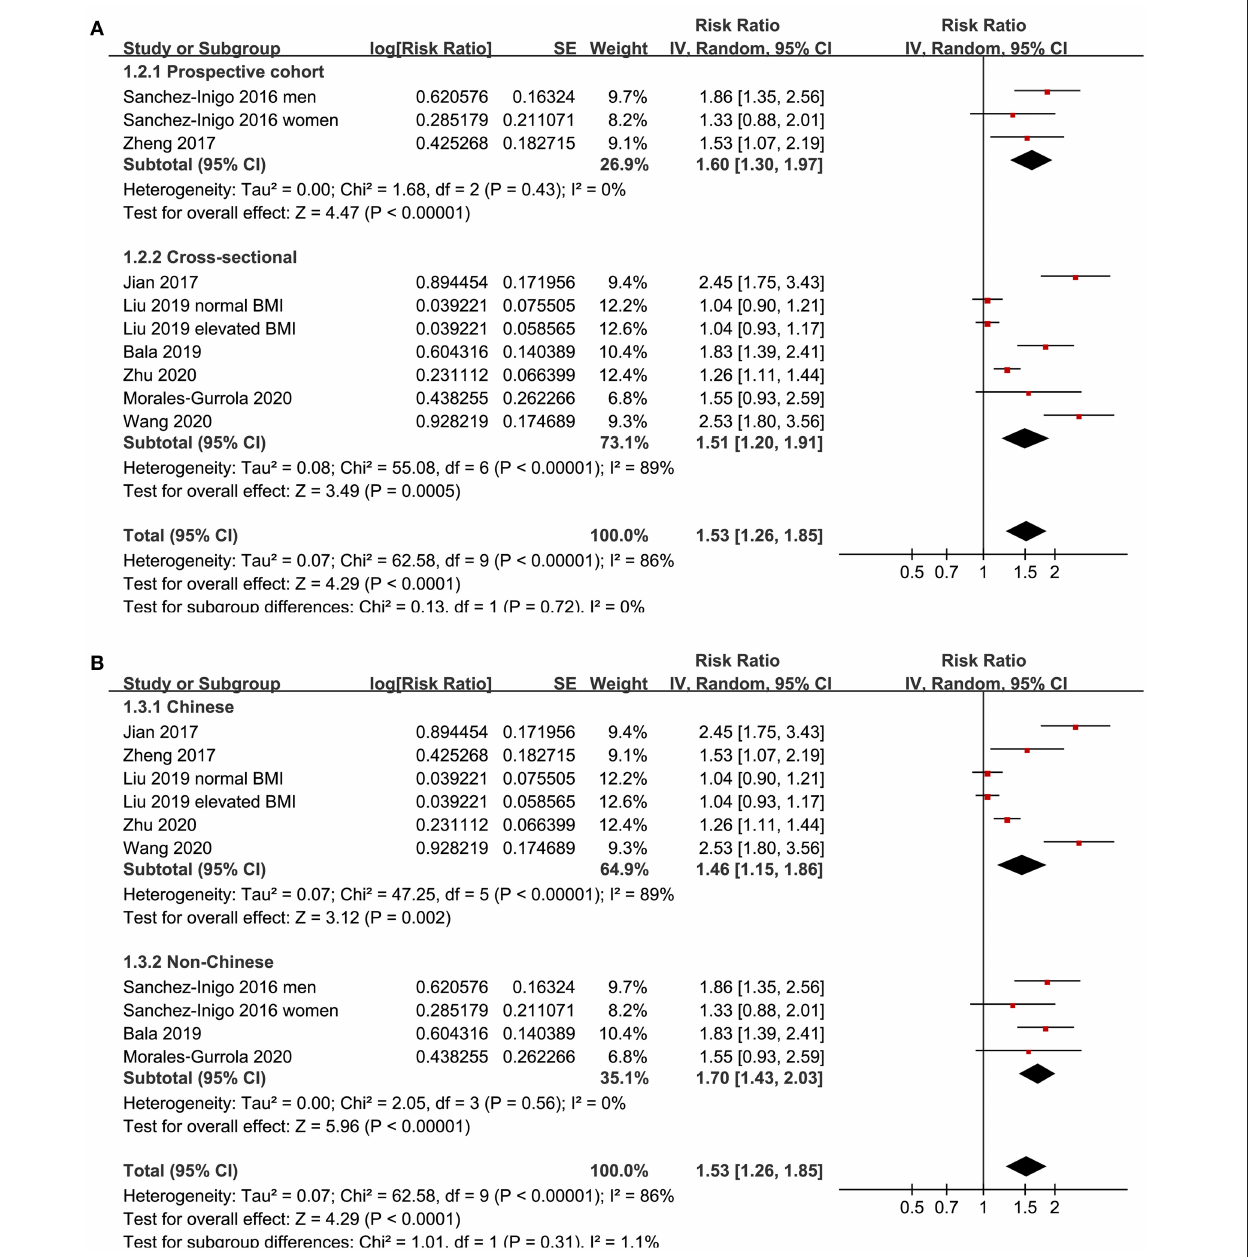
FIGURE 3 | Subgroup analyses for the association between TyG index and hypertension in community-derived adult population; (A) subgroup analysis according to the study design; and (B) subgroup analysis according to the ethnicity of the